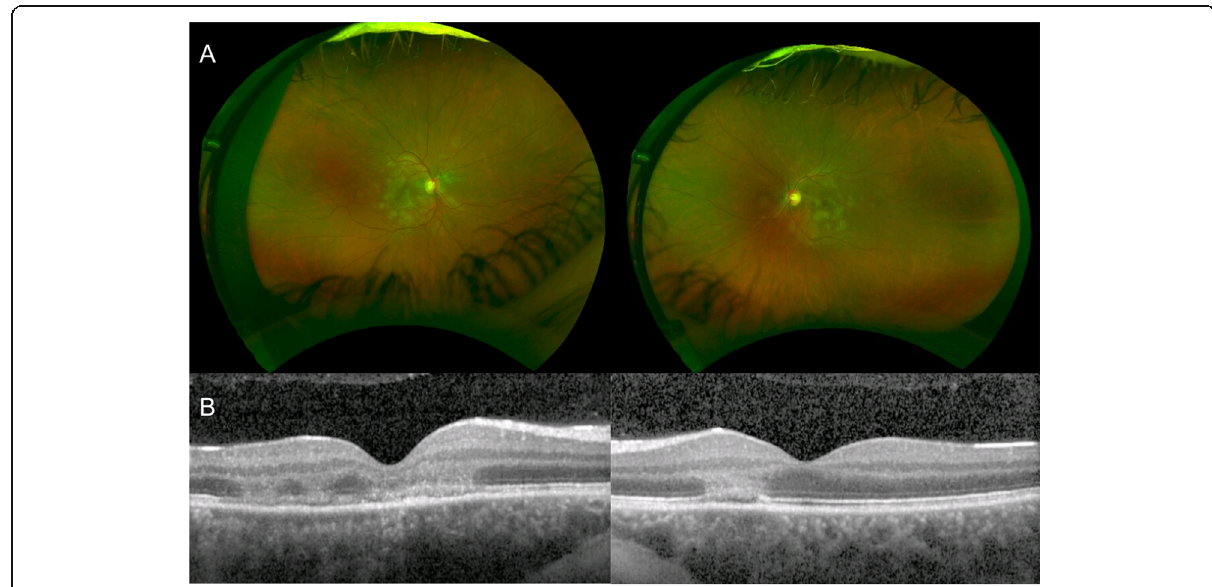
Fig. 2 Acute Posterior Multifocal Placoid Pigment Epitheliopathy. A Ultra-wide field color fundus photograph of both eyes showing multifocal, yellowish creamy, placoid lesions, located at the posterior pole. B Optical coherence tomography (OCT) of both eyes showing disruption of the outer retinal and ellipsoid zone, with hyperreflectivity involving outer nuclear layer with areas of hyperreflectivity appearing in continuity with